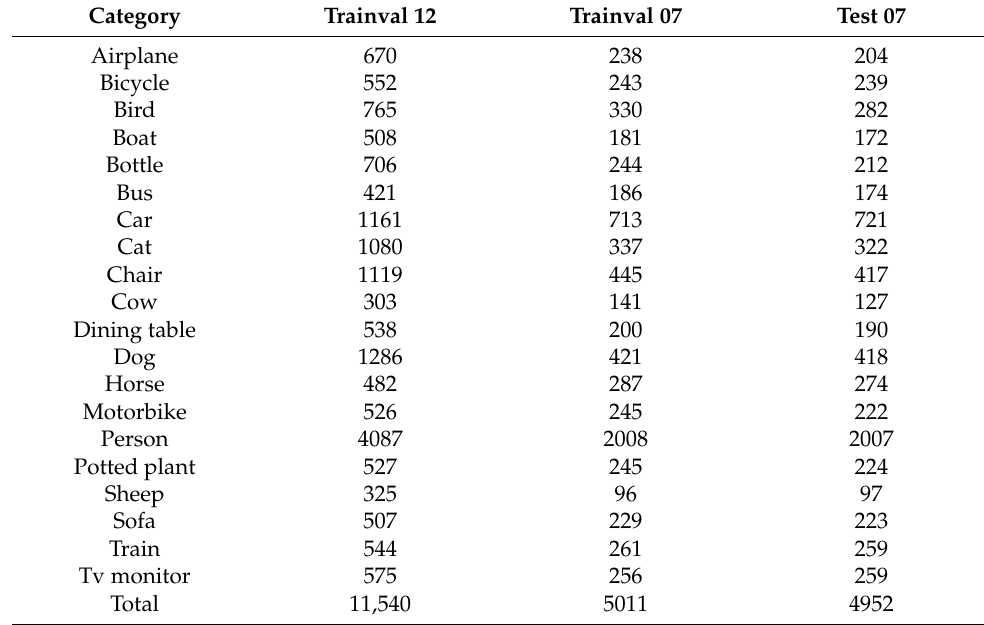
Table 2. The categories in the PASCAL VOC 2007 and the number of images. The PASCAL VOC 2012 has the same categories, but different numbers of